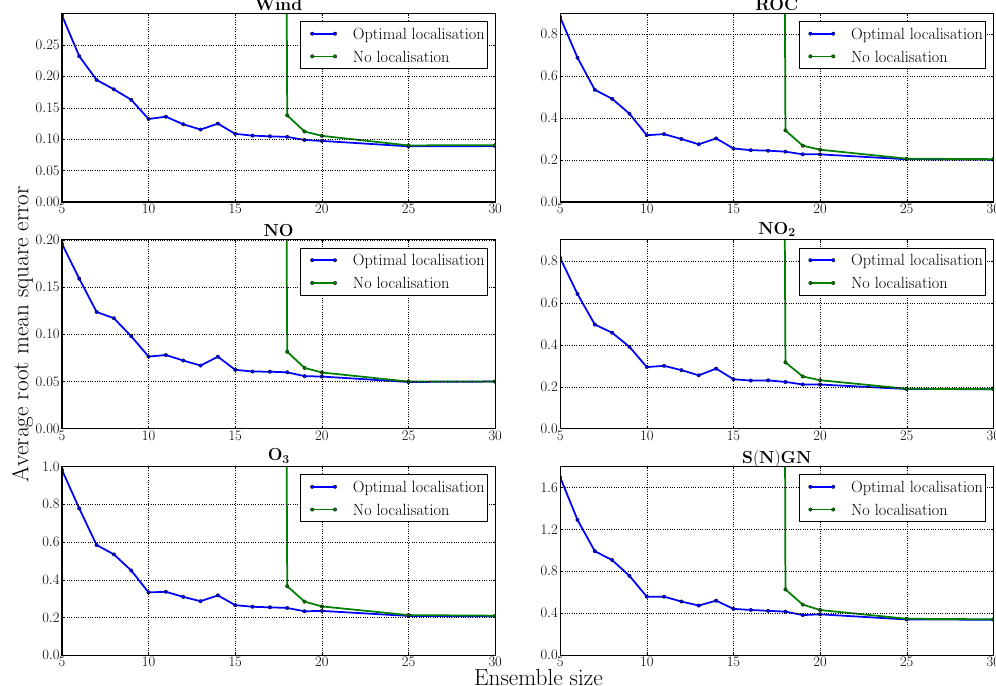
Figure 11. Average filtering analysis RMSEs of the L95-GRS variables, as a function of the ensemble size for the DEnKF without local- isation or with optimally tuned localisation radius. The L95 variables, flagged “Wind”, are shown with the original Lorenz unit, while the concentration unit is ppb (ppbC for